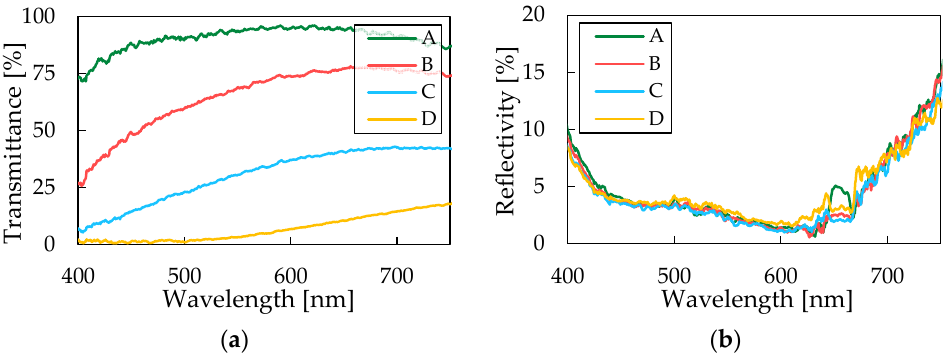
Figure 14. Transmission ( a ) and reflectivity ( b ) changes over time for 12 μ m diffuser cell.